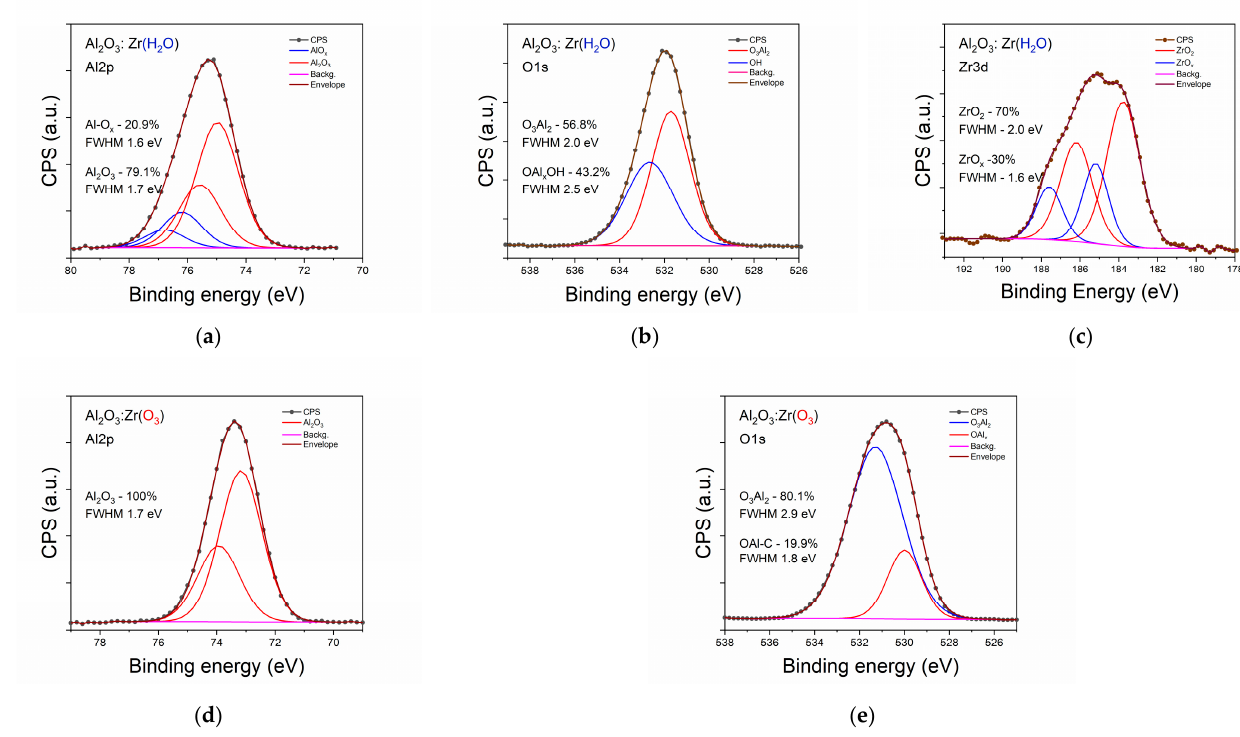
Figure 3. High-resolution spectra for metals and oxygen for investigated samples of pure Al 2 O 3 doped with Zr ions as measured for bulk, after short Ar + sputtering to remove surface contamination: with water ( a – c ), with ozone ( d , e ).